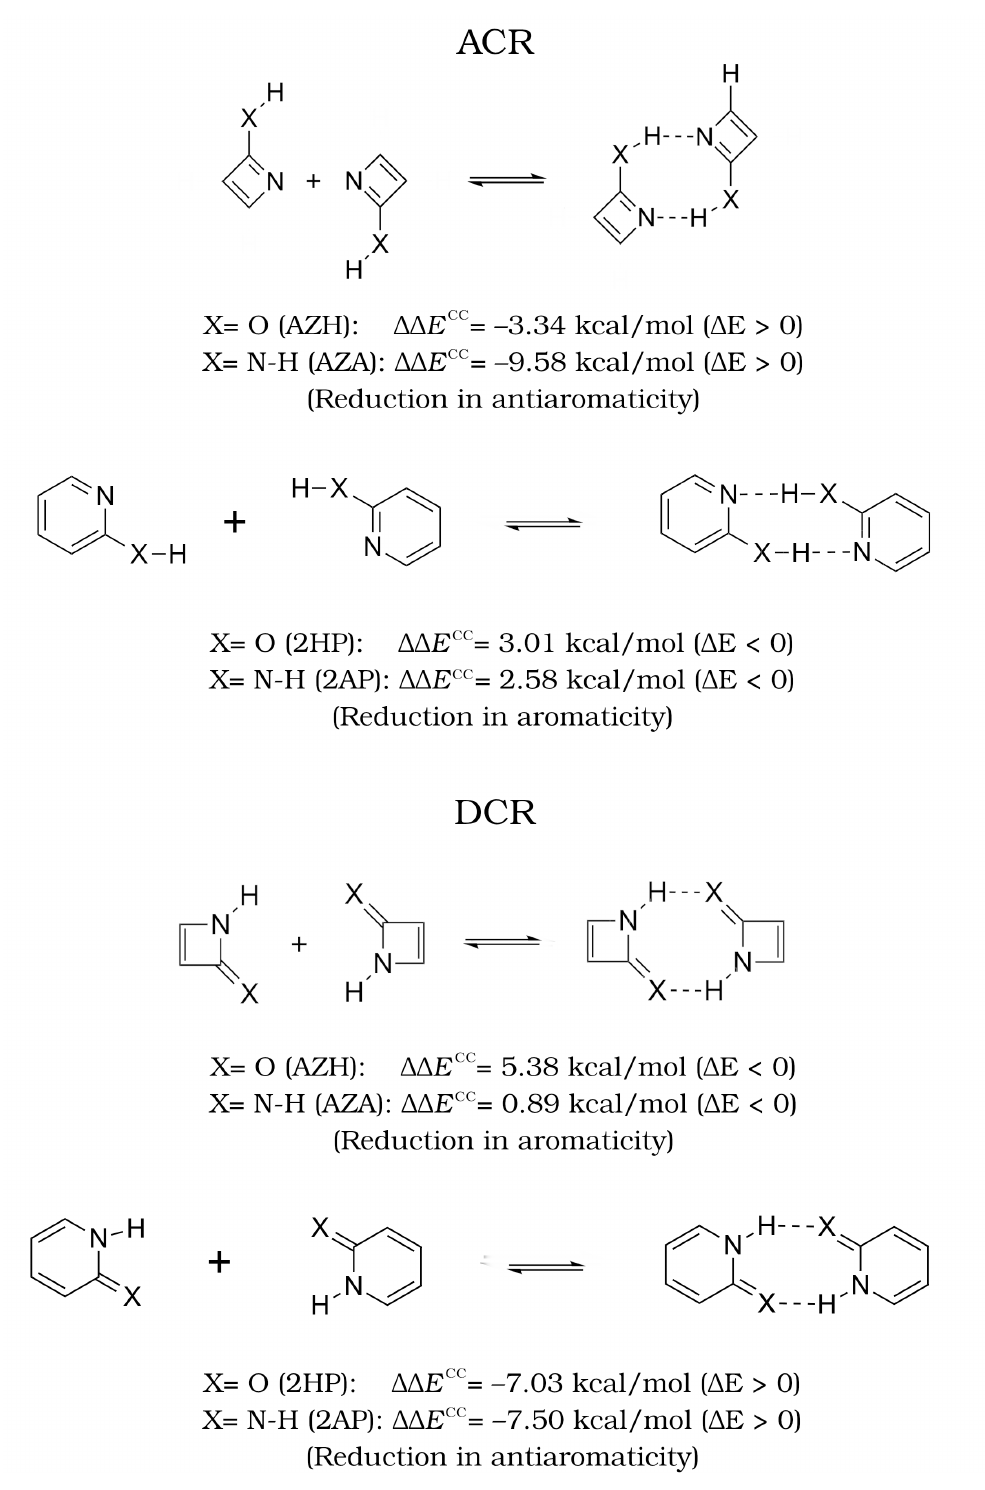
Figure 6. Values of ∆∆ E and changes in aromaticity and antiaromaticity ( ∆Γ ) for the AMHB investi- gated